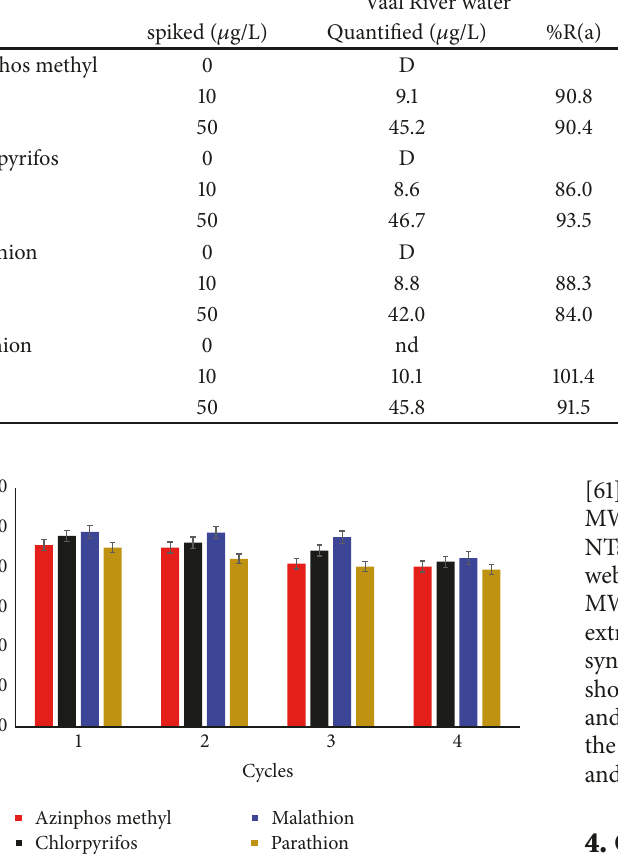
Figure 8: Recycling and reuseof theFe 3 O 4 @SiO 2 @MWCNTadsor- bentintheremovalofazinphosmethyl,chlorpyrifos,malathion,and parathion mix from aqueous